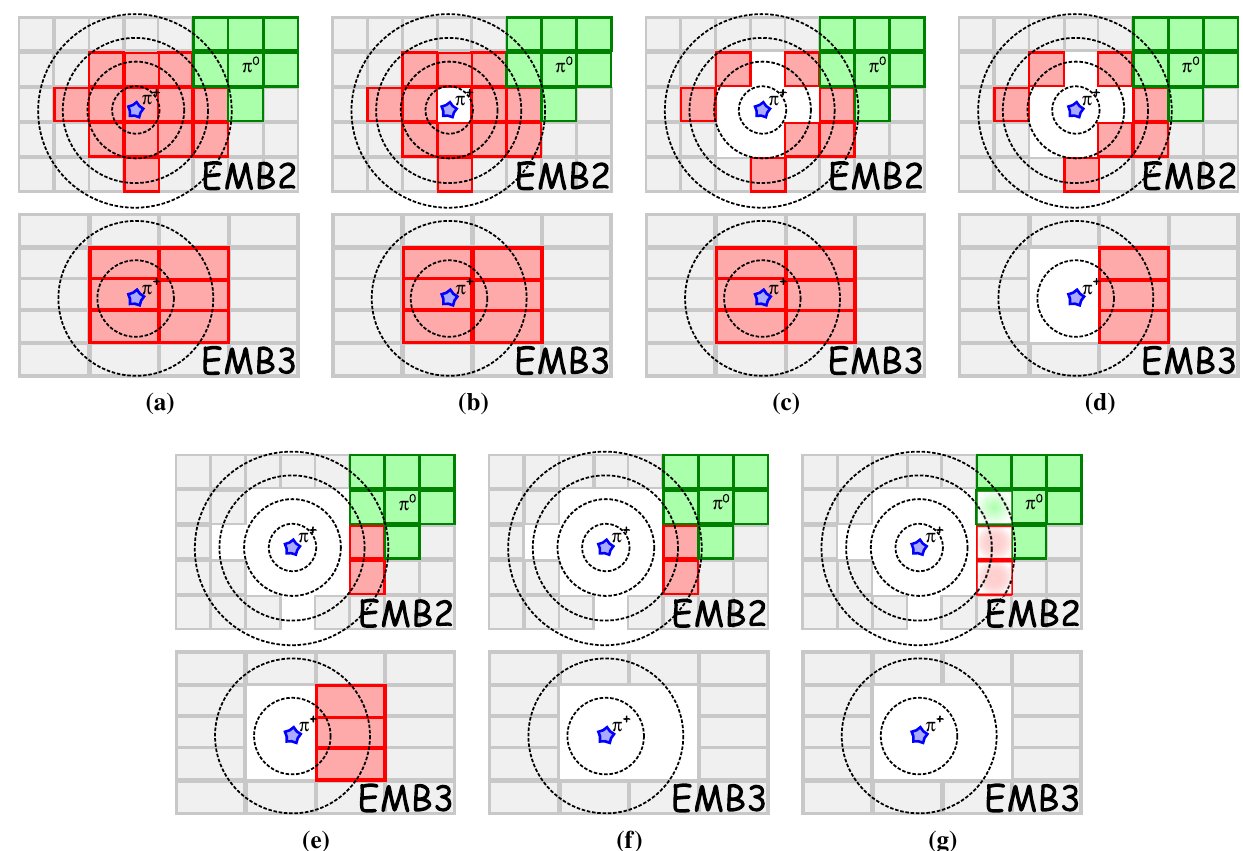
Fig. 15 An idealised example of how the cell-by-cell subtraction works. Cells in two adjacent calorimeter layers (EMB2 and EMB3) are shown in grey if they are not in clusters, red if they belong to a π + cluster and in green if contributed by a π 0 meson. Rings are placed around the extrapolated track (represented by a star ) and then the cells in these are removed ring by ring starting with the centre of the shower